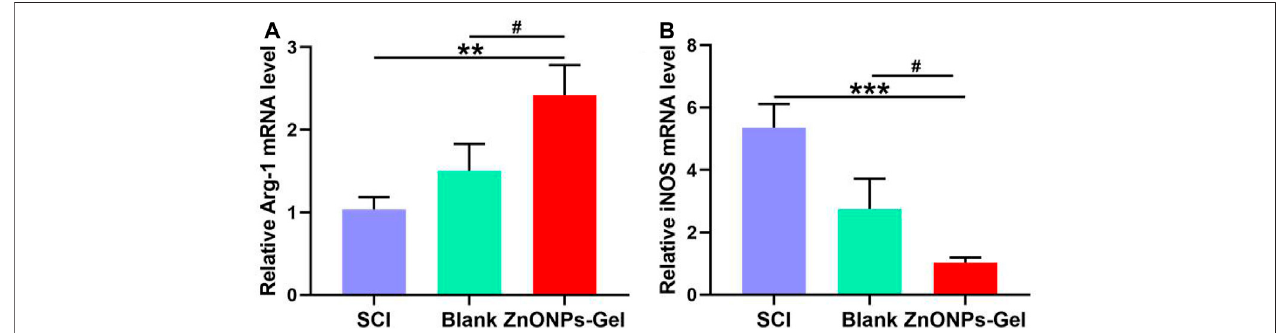
FIGURE 6 | ZnONPs-Gel-polarized M2 markers after SCI. Quanti fi cation of expression of M1: iNOS (A) or M2 markers: Arg-1 (B) in the injured spinal cord of SCI group,blankgroup,orZnONPs-Gelgroupat7 daysduringtheacutecourseofSCI.Dataaremean ± SD( n (cid:2) 3);*signi fi cantdifferencecomparedtoSCIgroup(* p < 0.05; ** p < 0.01; *** p < 0.001); #, compared to the blank group (# p < 0.05).